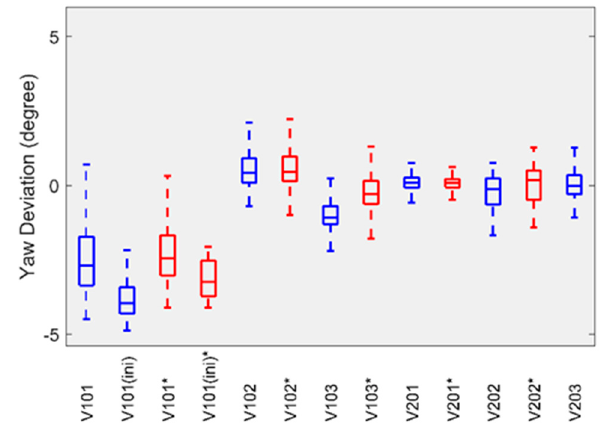
Figure 5. The yaw error of our implementation on Vicon room datasets.